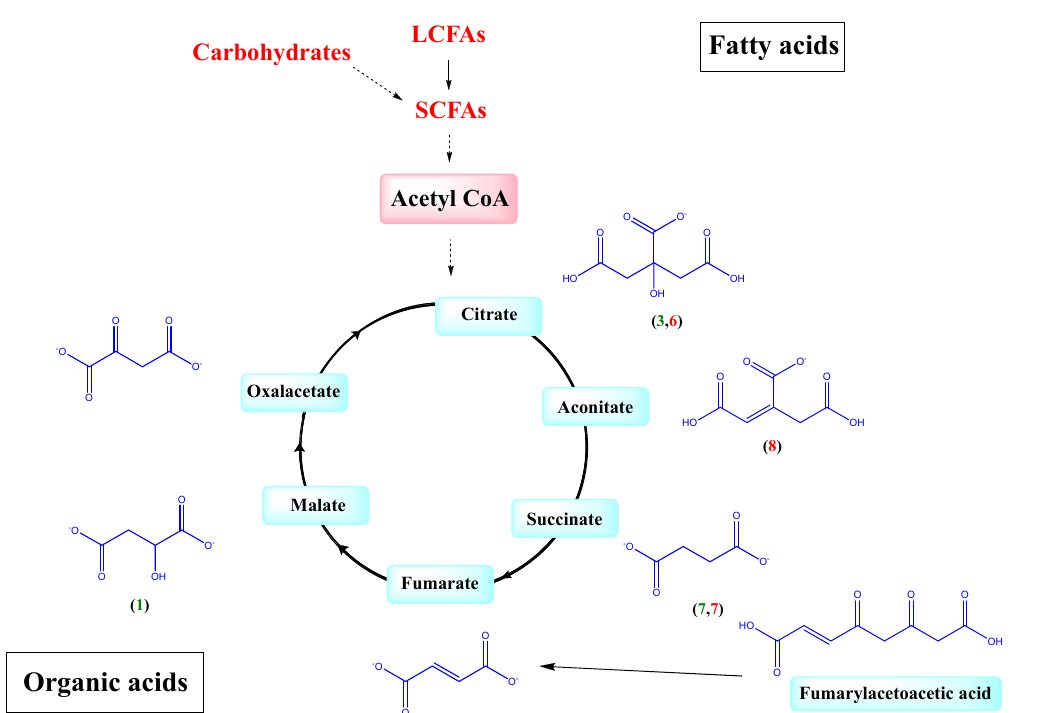
Figure 4. Proposed biotransformation pathways of fatty and organic acid mediated by the glyoxylate pathway, (number) peak number of metabolites; green in in vitro assay and red in ex vivo assay as present in Table 1 and Supplementary Table S2.